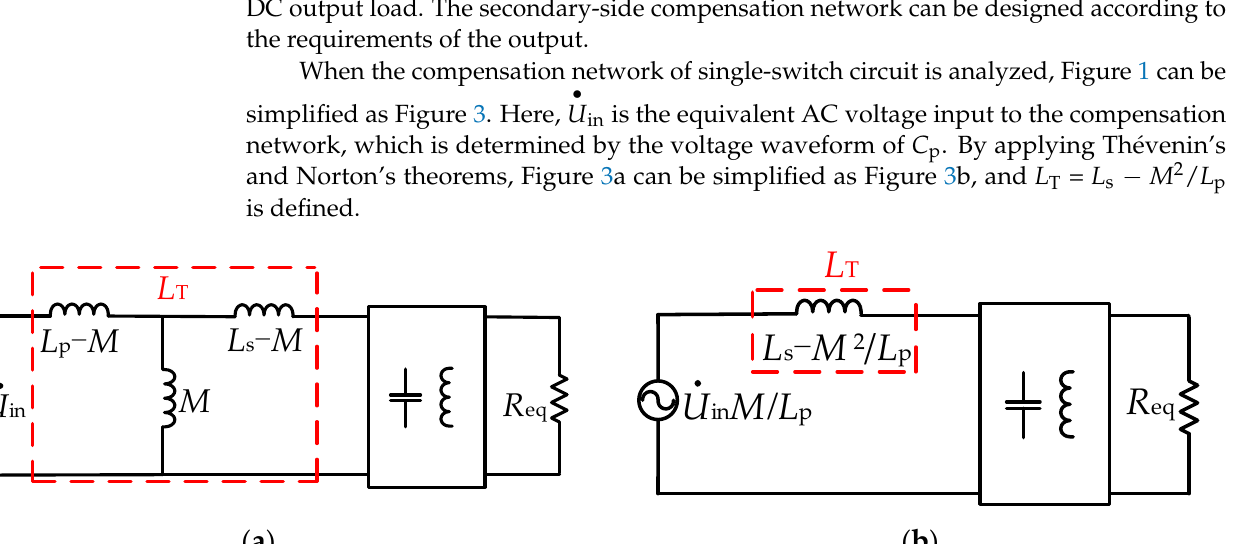
Figure 4. Hybrid topology of single-switch circuit. ( a ) The hybrid P-LC or P-S compensation network; ( b ) the proposed hybrid P-LCC or P-S compensation network.